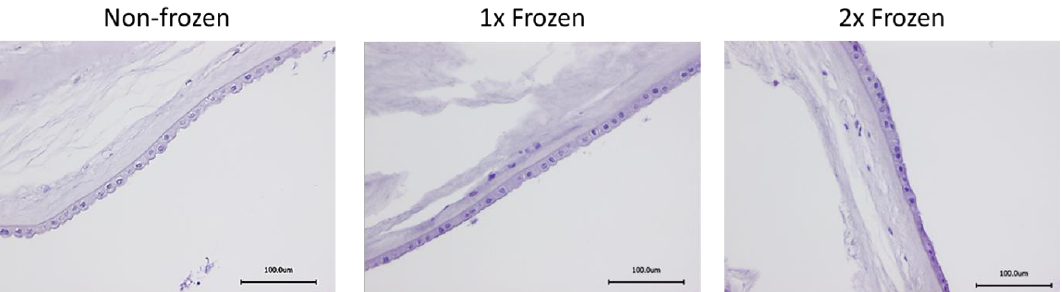
Figure 2. Representative histology images of the non-frozen, one-time frozen (1×) and two times frozen (2×) hAM. Hematoxylin and eosin (HE) staining displayed similar morphology of the hAM after all studied temperature modes. Scale bar 100 µm.